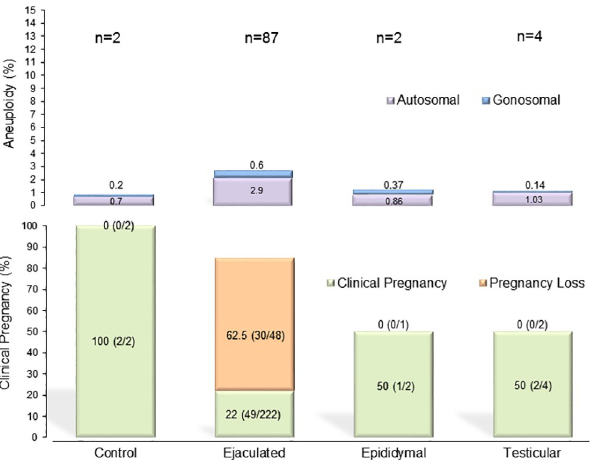
Fig 1. Sperm aneuploidy assessed by FISH in specimens of different origins with related pregnancy outcome. The two-sample t -test and the Mann-Whitney U test were used to compare the autosomal and gonosomal aneuploidy rates assessed by FISH in at least 1000 spermatozoa of ejaculated (n = 87), testicular (n = 4), and epididymal (n = 2) specimens in comparison to the donor control group (n = 2) (Upper graph). Friedman’s Chi-square test was then used to compare the clinical pregnancies and their evolution into miscarriage or term. These outcomes are represented according to the source of spermatozoa used for ICSI (Lower graph). No significant differences were found in both statistical comparisons.